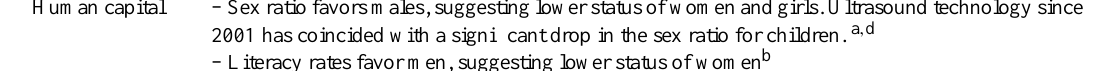
Table 1. Livelihood assets profile in Uttarakhand Himalaya, with special reference to women’s assets. Human capital – Sex ratio favors males, suggesting lower status of women and girls. Ultrasound technology